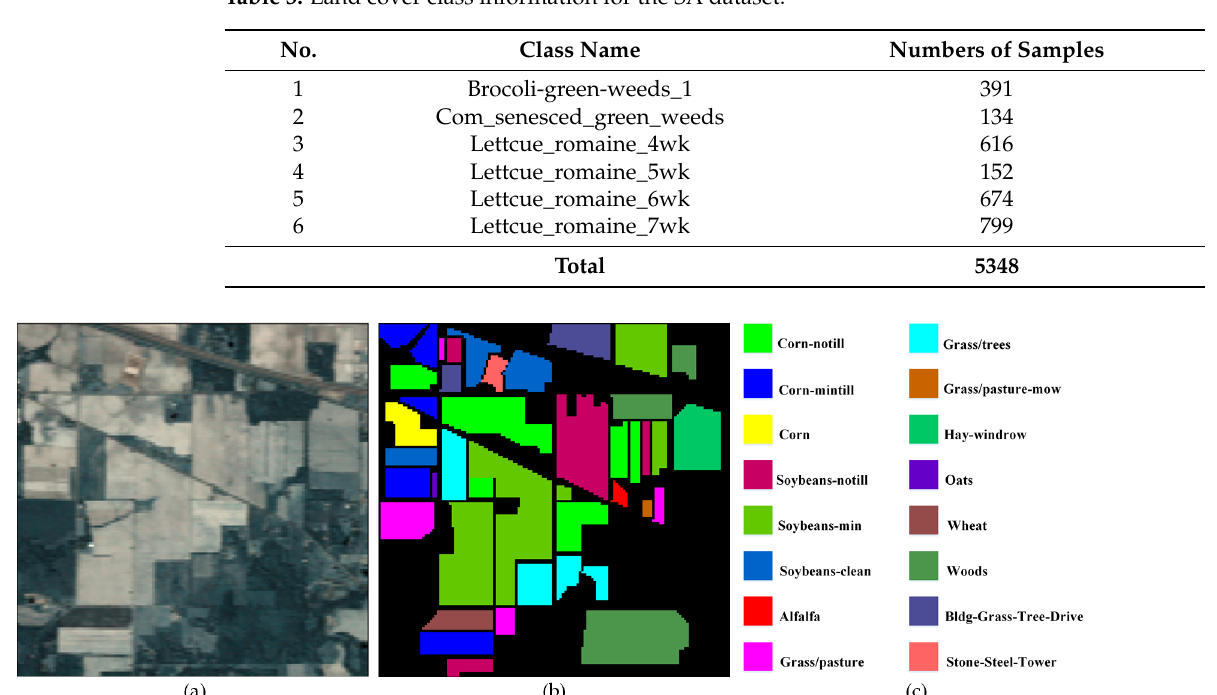
Figure 7. ( a ) False-color image, ( b ) Ground-truth image, and ( c ) Labels of the IN dataset.